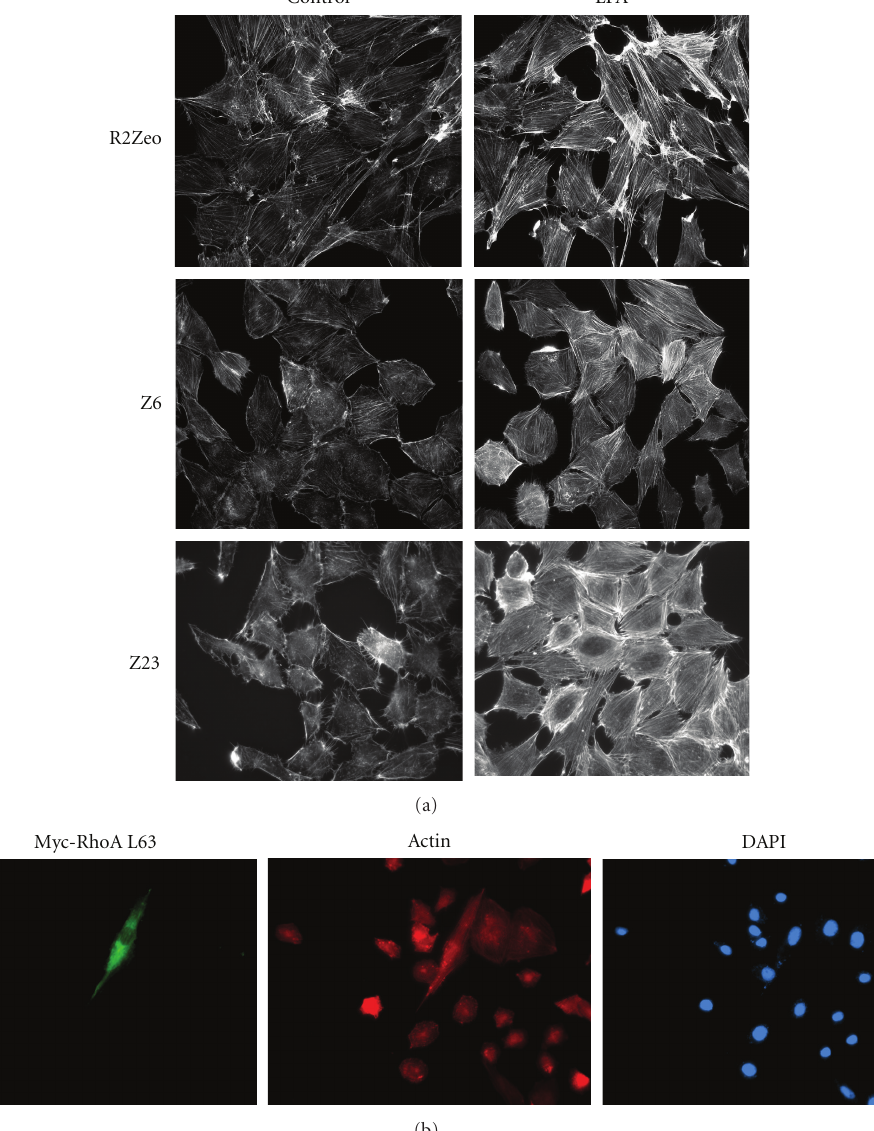
Figure 6: LPA stimulation and activated RhoA rescue actin stress fibers formation in fibroblasts overexpressing CKI γ 2. (a) Actin staining following LPA stimulation (50ng/mL, 10–30 minutes, and 37 ◦ C) in serum-starved fibroblasts control (R2Zeo) or stably overexpressing CKI γ 2 (Z6 and Z23). Pictures were taken at 63X. (b) Myc, Actin, and DAPI staining of CKI γ 2 overexpressing fibroblasts (Z23)